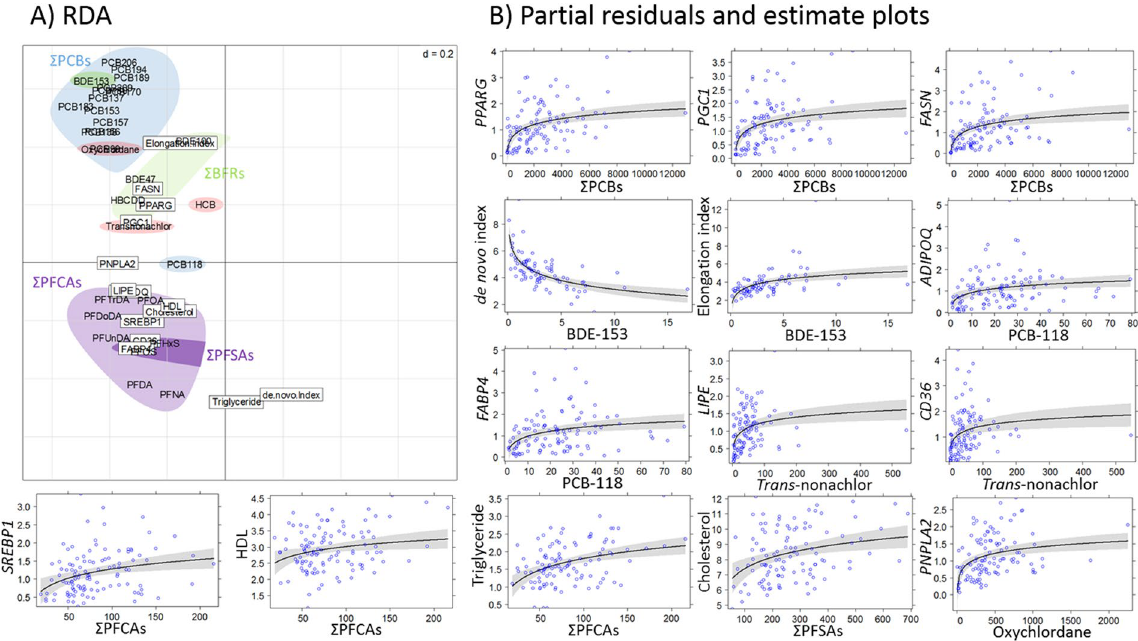
Figure 1. Relationships between biomarkers of energy metabolism and pollutants. ( A ) Redundancy analysis (RDA) loading plot (n = 80) and ( B ) partial residuals and estimate plots obtained from mixed models (n = 111). Plasma and fat samples are from Svalbard female polar bears captured during spring (April) and autumn (September) 2012 and 2013. For the RDA ( A ), boxed labels are response variables and unboxed labels are predictors. ( B ) Dots are the partial residuals, the solid line is the parameter estimate and the grey area represents its 95% confidence interval derived from mixed models. Pollutant concentrations are in ng/g wet weight, transcript levels are in arbitrary units, lipid parameters in